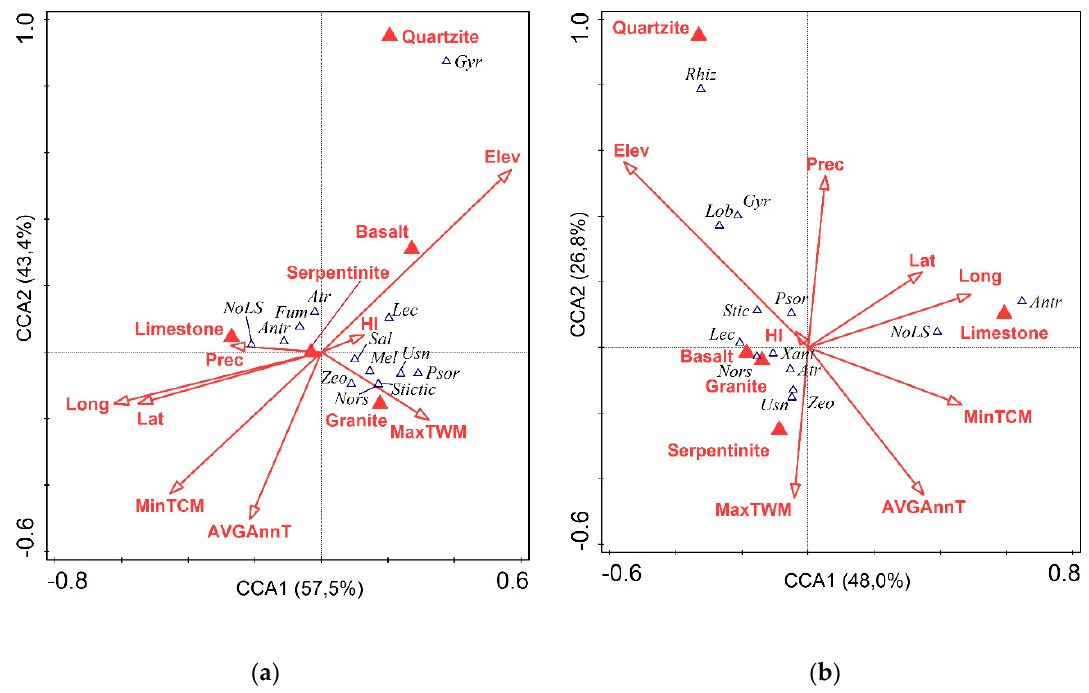
Figure 6. CCA ordination plot showing the cover of lichens containing di ff erent secondary metabolites in relation to climatic factors. ( a )—Foliose and fruticose species, ( b )—Crustose species. Abbreviations of names of the secondary metabolites include the first three or four letters. AVGAnnT—average